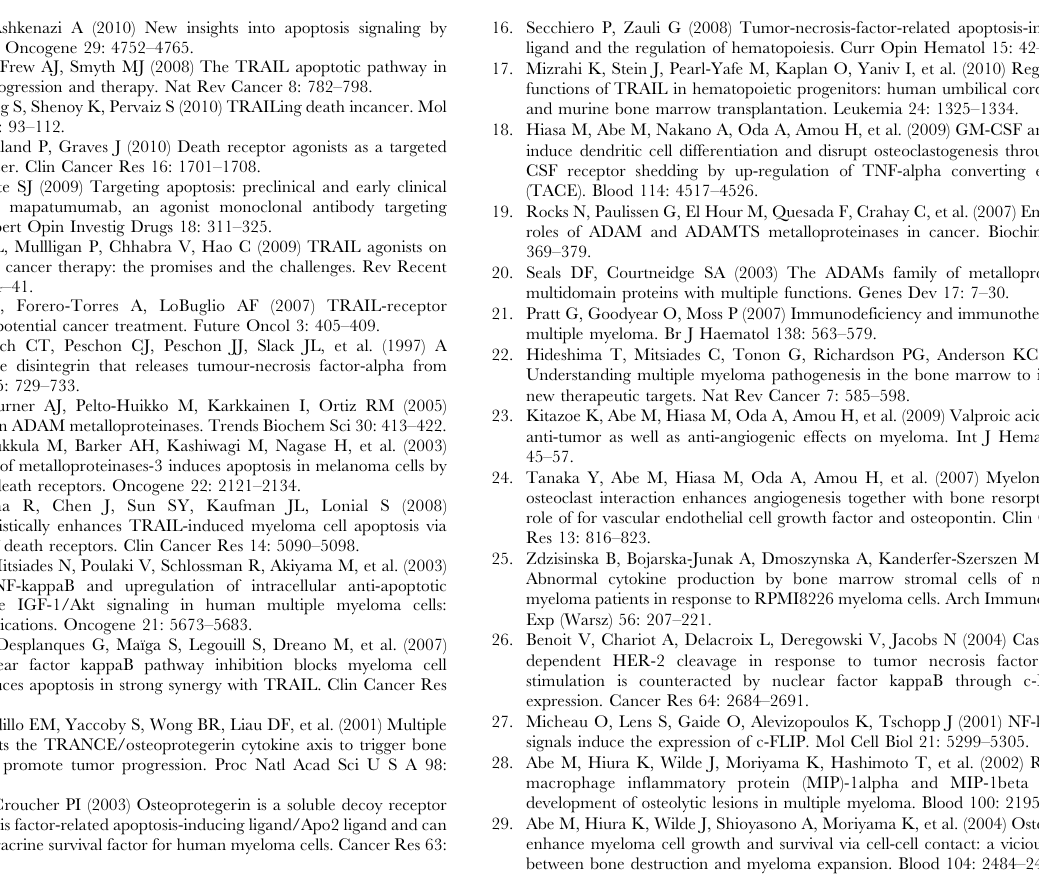
Figure S1 DR4 mRNA expression. RPMI8226, U266, OPC, TSPC-1, KMS12-BM, and MM.1S cells were cultured for 6, 12 and 48 hours in the presence or absence of TAPI-0 at 10 m M as indicated. DR4 mRNA expression was analysed by RT-PCR in RPMI8226 and U266 cells. GAPDH was used for quantity